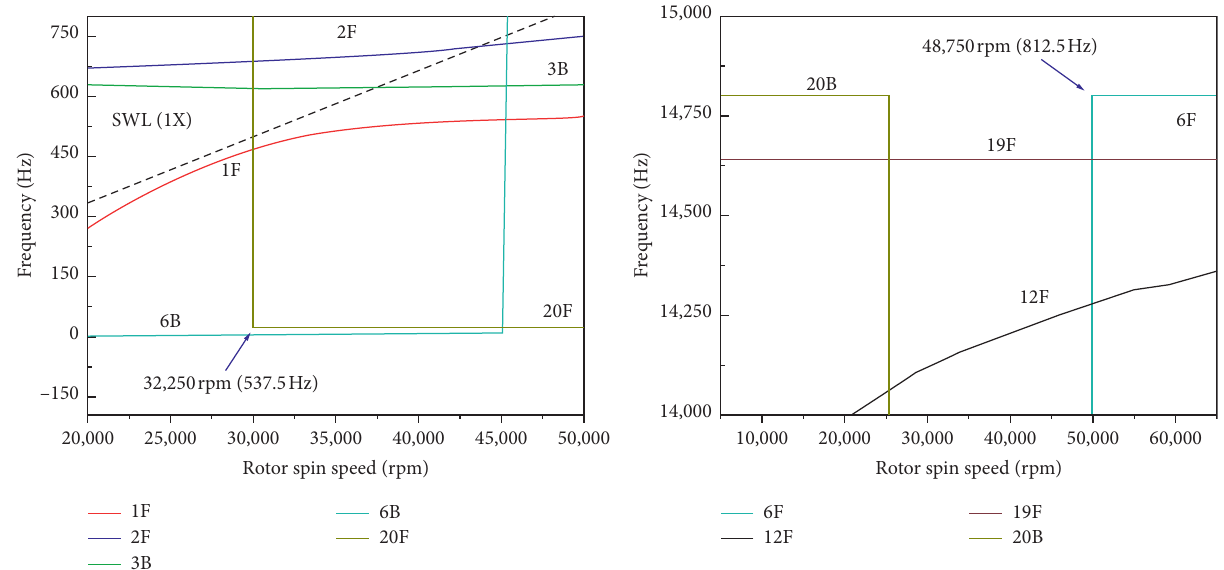
Figure 22: Partial enlargement of Campbell diagram (case 1).